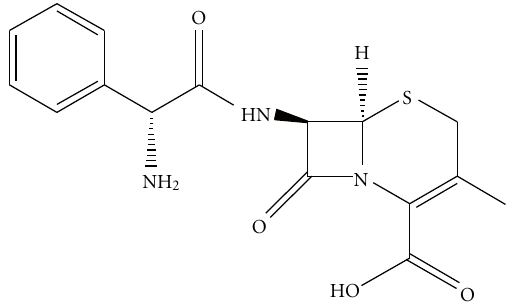
F 1: e structure of cephalexin (the isoelectric point, pI=4.3).